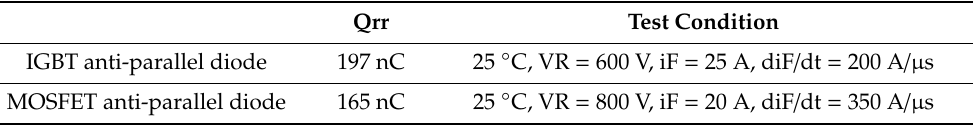
Table 2. Diode reverse recovery loss comparison.